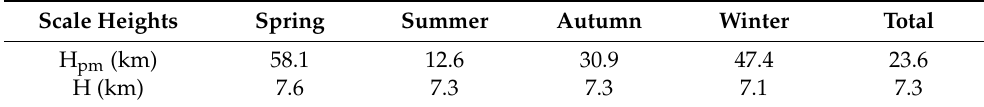
Table 2. Scale Heights (H pm and H).